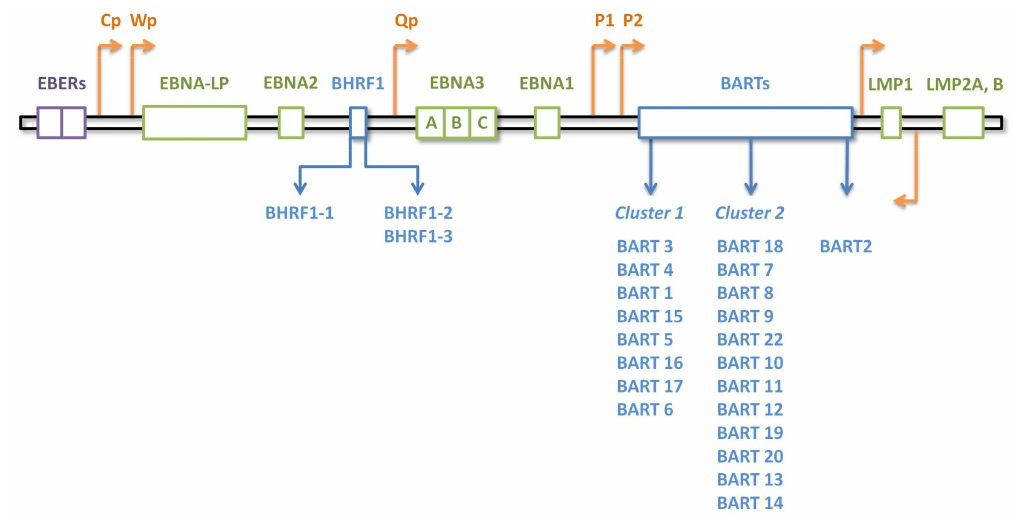
Figure 1. The structure of the EBV genome encoding latent products. Orange arrows indicate promoters. Blue boxes indicate miRNA coding regions. BART : BamHI-A rightward transcript; BHRF1 : BamHI fragment H rightward open reading frame 1; Cp: C promoter; EBERs : EBV-encoded small RNAs; EBNA1 : EBV-encoded nuclear antigen 1; EBNA2 : EBV-encoded nuclear antigen 2; EBNA3 : EBV-encoded nuclear antigen 3; EBNA-LP : EBV-encoded nuclear antigen leader protein; LMP1 : latent membrane protein 1; LMP2 : latent membrane protein 2; P1: promoter 1; P2: promoter 2; Qp: Q promoter; Wp: W